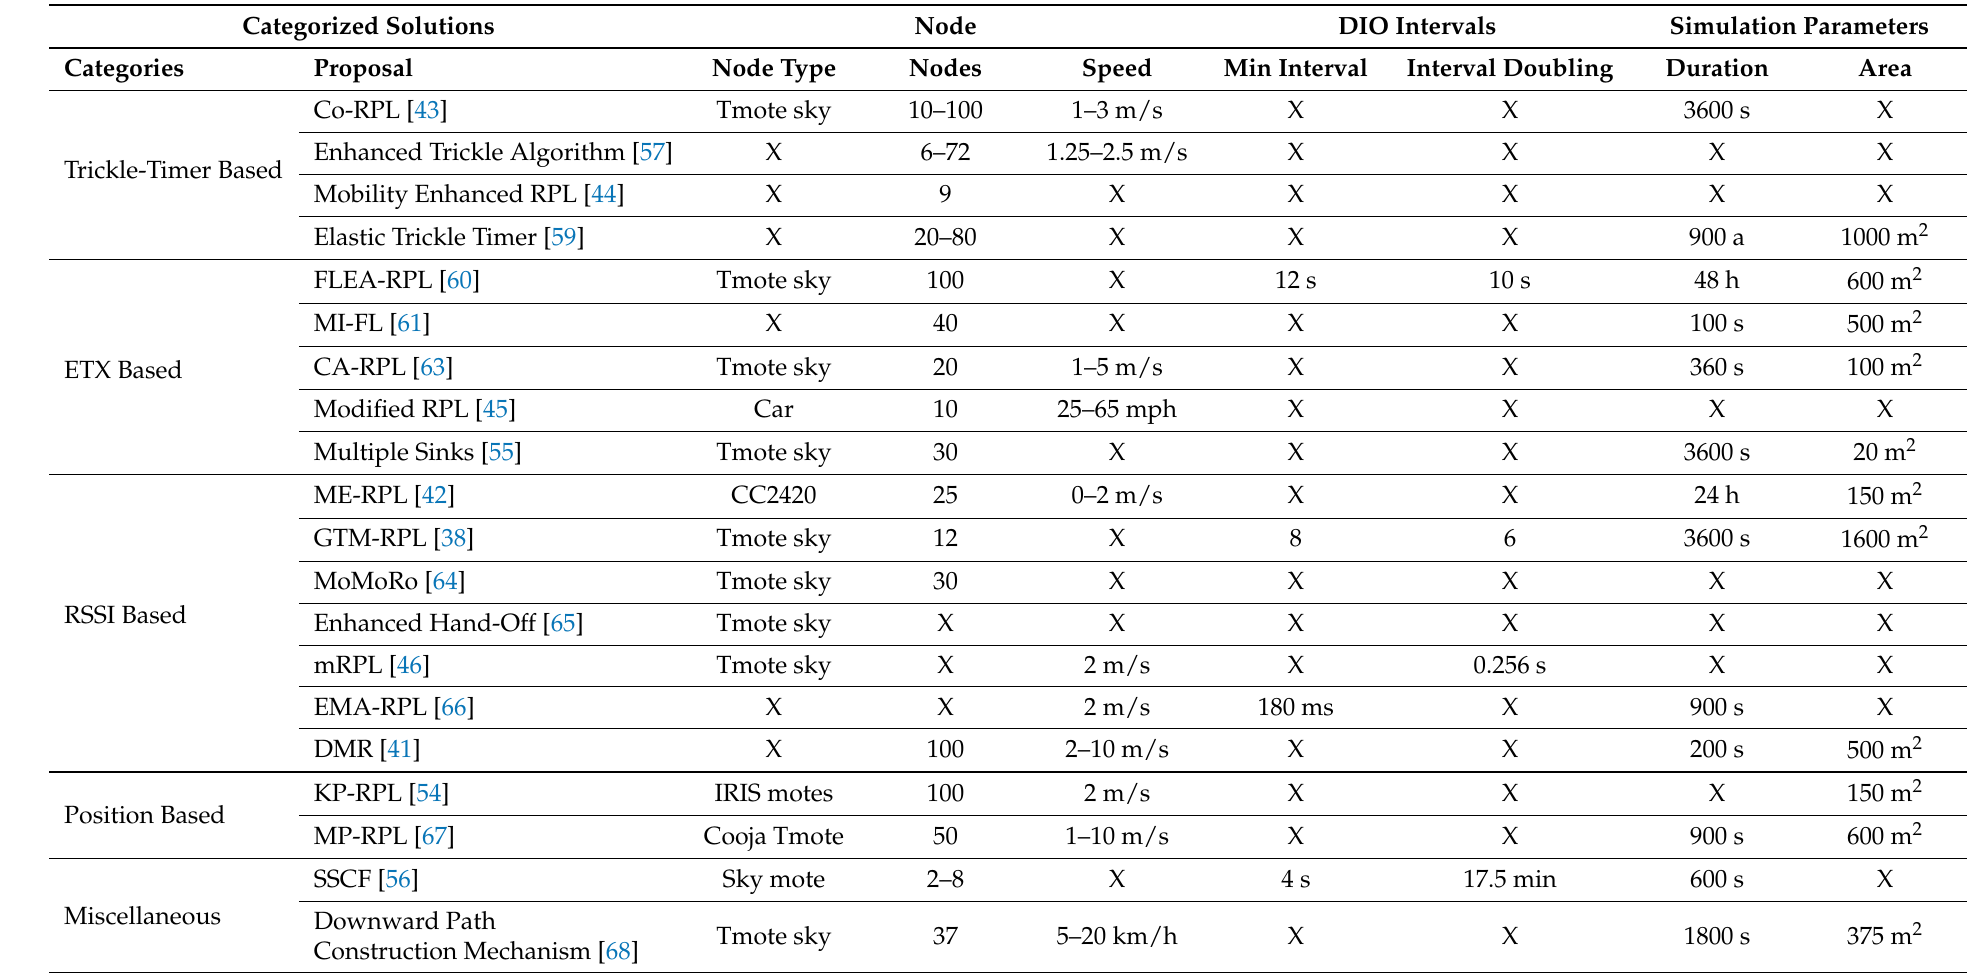
Table 6. Comparison of Various Solutions in terms of Different